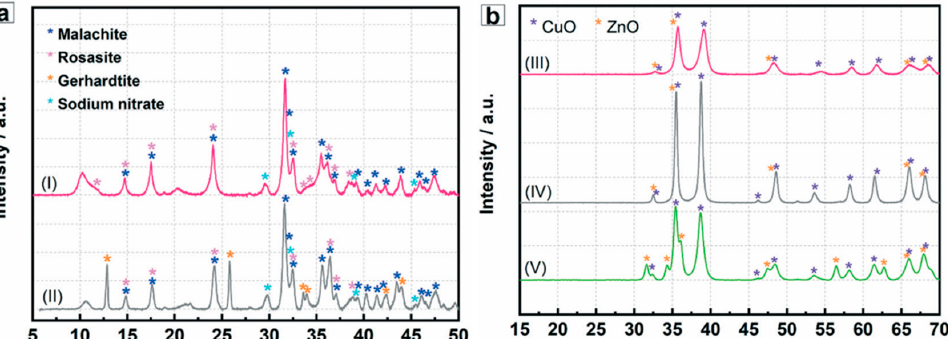
Figure 8. XRD analysis results of uncalcined ( a ) and calcined ( b ) CuZnAl precipitates showing primary precipitates synthesized in microfluidic (I) and batch reactor (II); and microfluidic Cu/ZnO/Al 2 O 3 (III), batch reactor Cu/ZnO/Al 2 O 3 (IV) and batch reactor Cu/ZnO (V) [42]. Reprinted from an open access